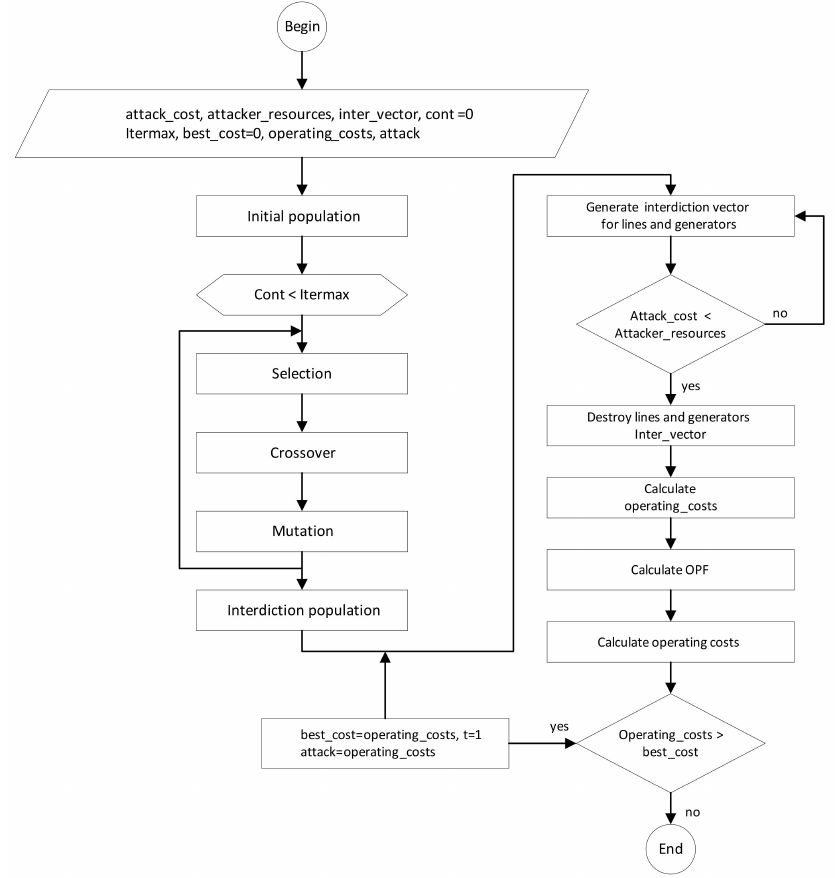
Figure 3. Flowchart of the proposed